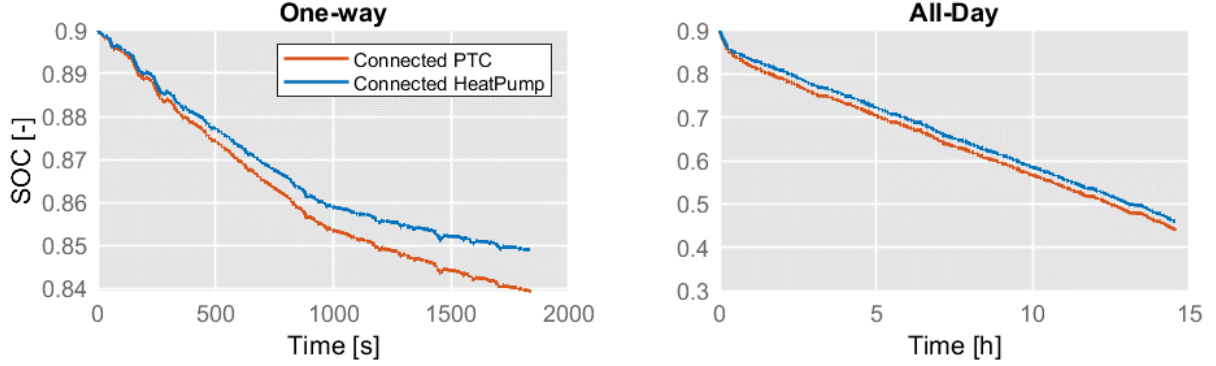
Figure 23. SOC variation throughout time comparing the heating systems for the driving cycle of route 18.